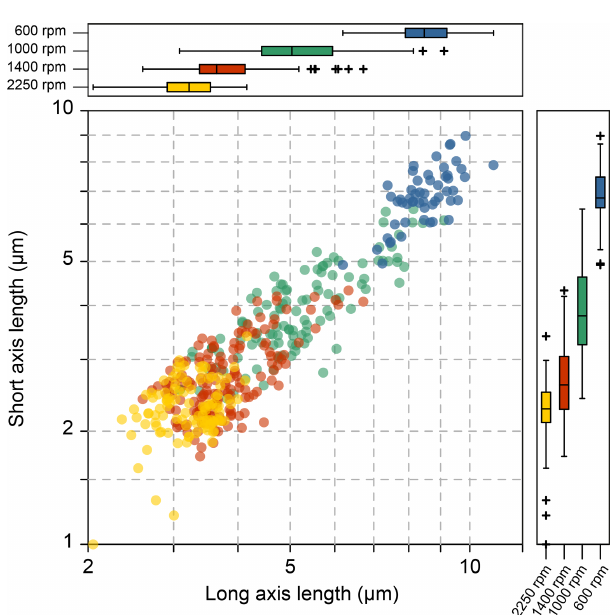
Figure 3. The coccolith size in different fractions after centrifuge separation: the yellow, red, green and blue dots represent 2250rpm for 2min, 1400, 1000 and 600rpm for 1min,